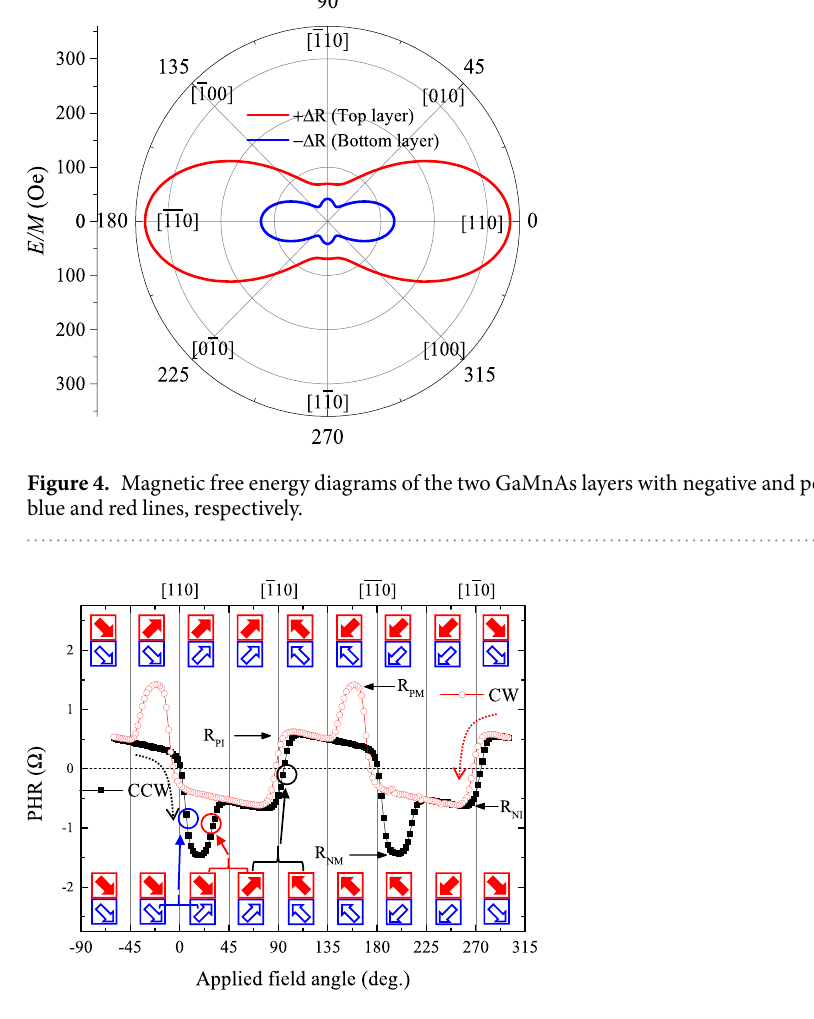
5 ScieNtific REPORTS | (2018) 8:2288 | DOI:10.1038/s41598-018-20749-8